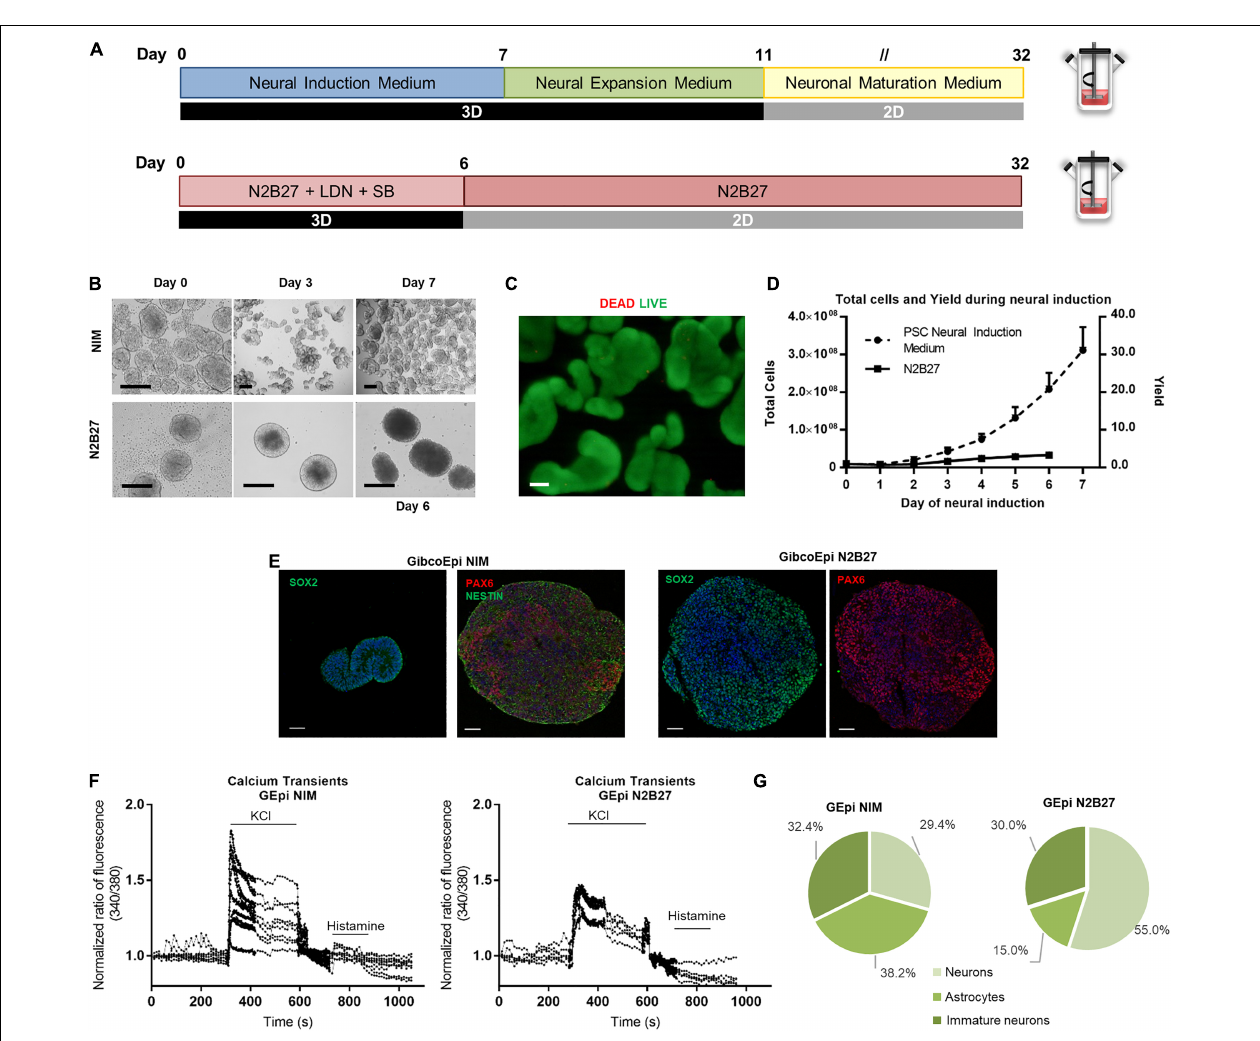
FIGURE 3 | Efficient and scalable generation of neural progenitors using Neural Induction Medium in spinner flasks. (A) Schematic overview of neural induction of hiPSC on spinner flasks using Neural Induction Medium (NIM) and N2B27. (B) Bright field images of aggregates at day 0, 3, and 7 of neural induction. Scale bars: 300 µ m. (C) Viability of cells in 3D aggregates after hiPSC neural induction (NIM), using LIVE/DEAD staining kit. Green: calcein-AM; Red: Ethidium homodimer-1. Scale bars: 100 µ m. (D) Growth curves of hiPSC cultured in spinner flasks through 7 days of neural induction, using NIM or N2B27, for total cell number and cell yield. (E) Immunocytochemical analysis of hiPSC-derived neural progenitor aggregates obtained after neural induction in spinner flasks for Nestin, Pax6 and Sox2 expression. Nuclei were stained with DAPI. Scale bars: 50 µ m. (F) Single-cell calcium imaging (SCCI) analysis at day 34 of neural induction. (G) Percentage of neurons, immature neurons and glial cells calculated based on the response to KCl and histamine.